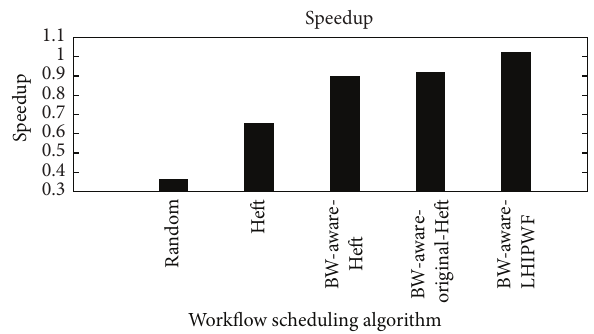
Figure 7: Comparison of the total data communication time for the workflow of 41 tasks with large data communication.